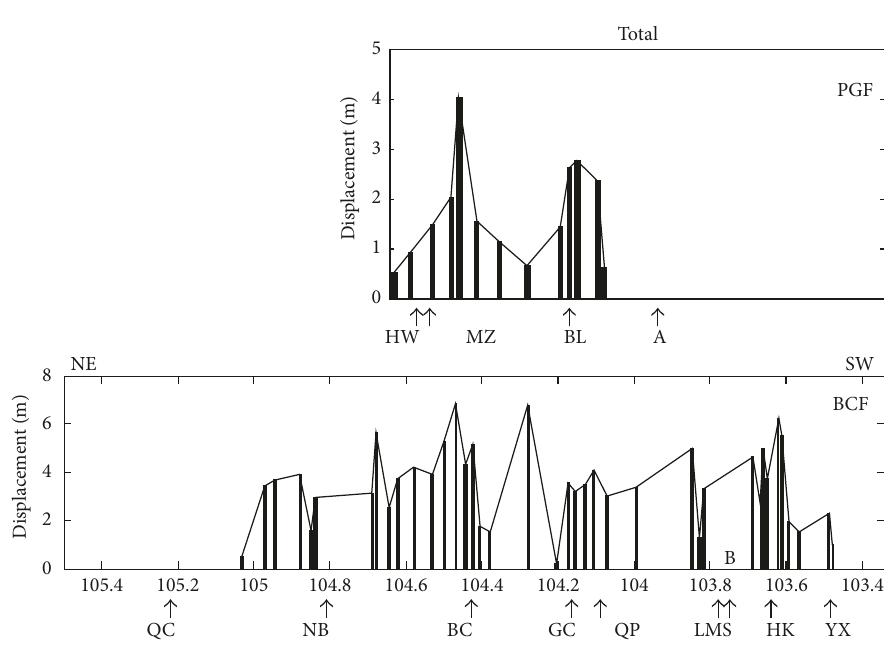
Figure 4: The slip values of shallowest subfaults of BCF and PGF according to the results of Xu et al. [1, 3,